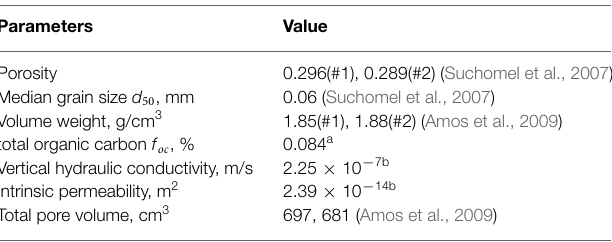
TABLE 2 | Column experimental